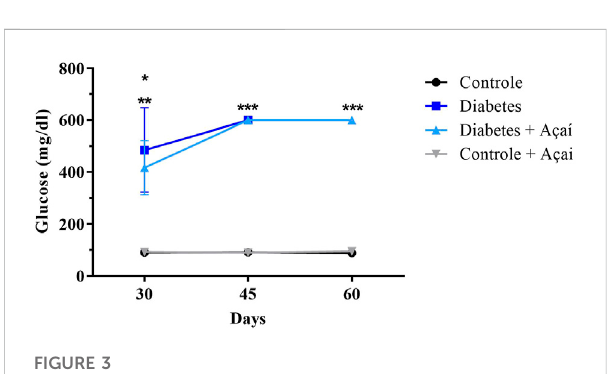
FIGURE 3 Blood glucose levels (mg/dL) monitoring after diabetes induction.Valuesaremeans±SD.** p < 0.001CTRandCTR+Açaívs. DMin30 days,* p < 0.01CTRandCTR+Açaívs.DM+Açaíin30 days, * p < 0.0001 CTR and CTR + Açaí vs. DM and DM + Açaí in 45 days, * p < 0.001 CTR and CTR + Açaí vs. DM + Açaí in 60